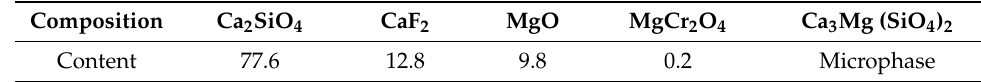
Figure 1. XRD diffraction pattern of the AOD slag. Table 2. Main mineral phase composition of AOD slag (mass %).